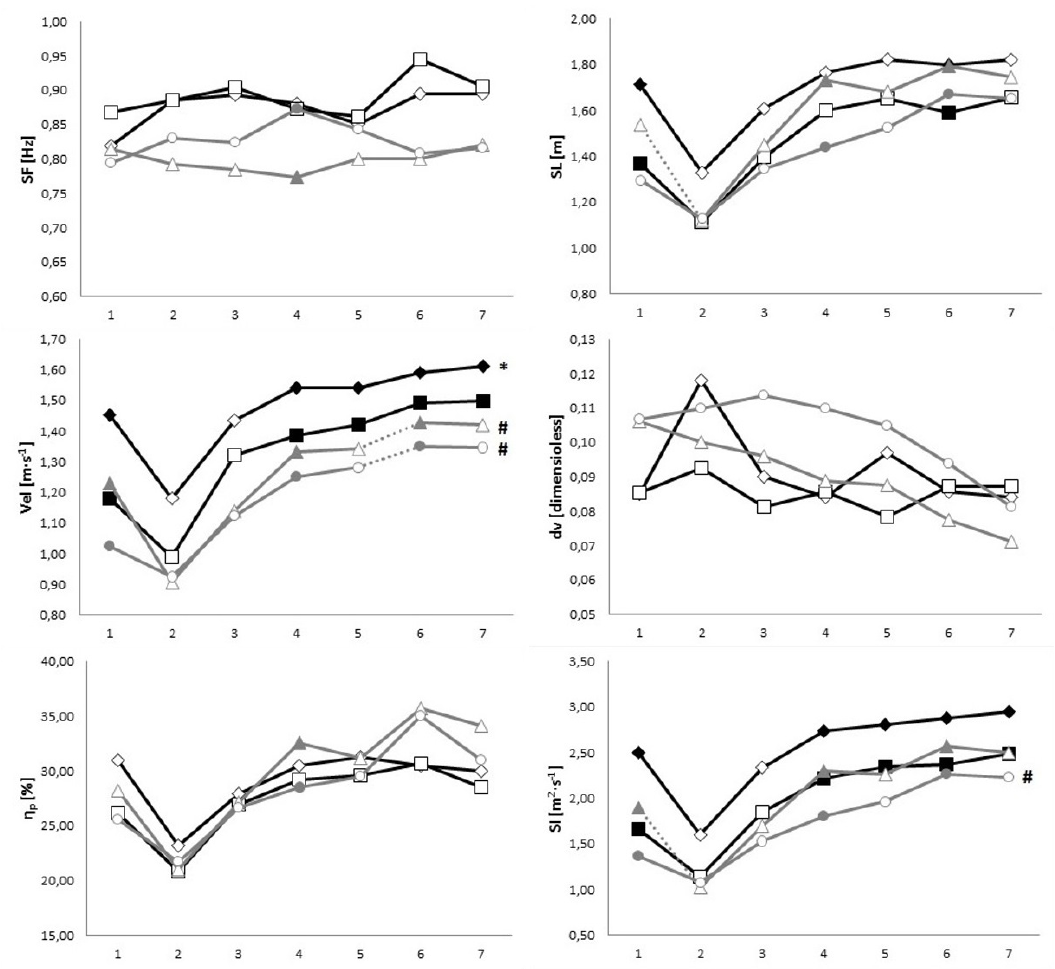
Figure 3. Kinematic and energetic variability along the two seasons. Black solid line (♦) (■) – boys sports level 1 and 2 respectively; grey solid line (▲) (●) – girls sports level 1 and 2 respectively; dot parts within solid line means significant differences ( p ≤ .05) between moments for each sports level; white background in the marker – no-significant differences ( p > .05) between sports level within each gender; SF – stroke frequency; SL – stroke length; v – swimming velocity; dv – speed fluctuation; η – propelling efficiency; SI – stroke index; * and # after each sports level p line – significant differences ( p ≤ .05) between initial (1) and final moment (7) for boys and girls,